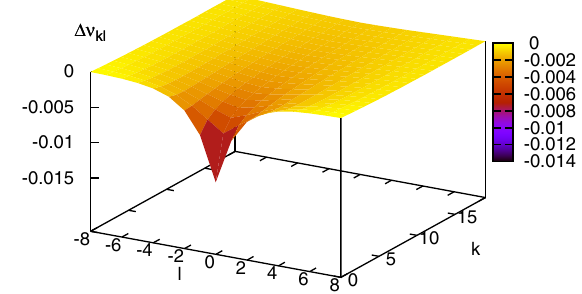
FIG. 4. Linear tune shift of the kl mode for the σ mode.